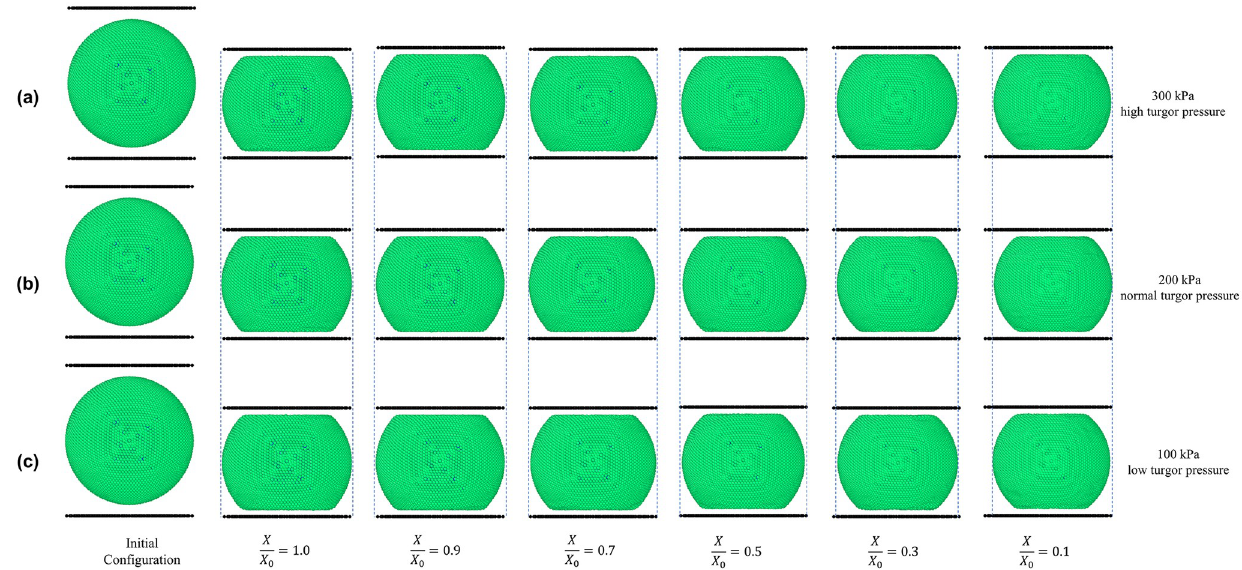
Fig 8. SPH-CG model predictions for compression of dried cells at different dryness levels. at: (a) high turgor pressure (300 kPa); (b) normal turgor pressure (200 kPa); (c) low turgor pressure (100 kPa). The blue dashed lines have been placed in order to facilitate the efficient identification of morphological changes among different turgor pressures. ( X/X 0 is the normalised moisture content).